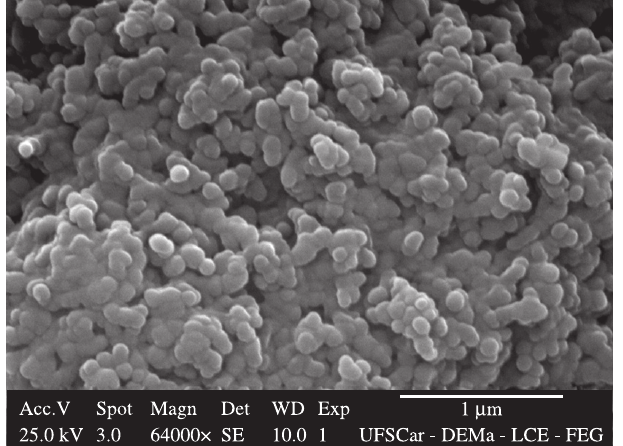
Figure 2. Morphology of calcium carbonate nanoparticles used in this work.